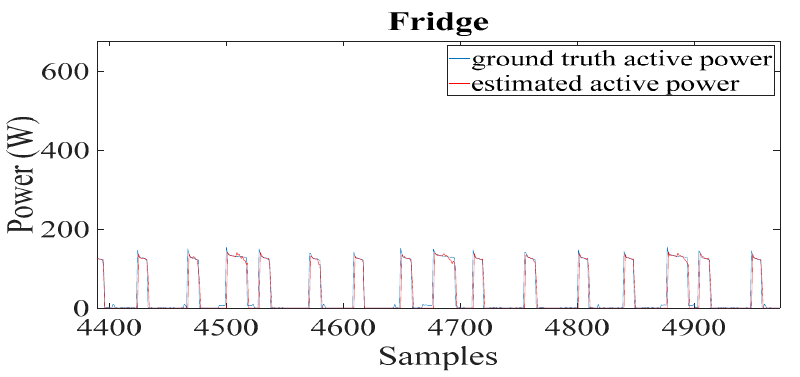
Figure 9. Fridge AMPD: blue, ground truth active power; red, estimated active power.